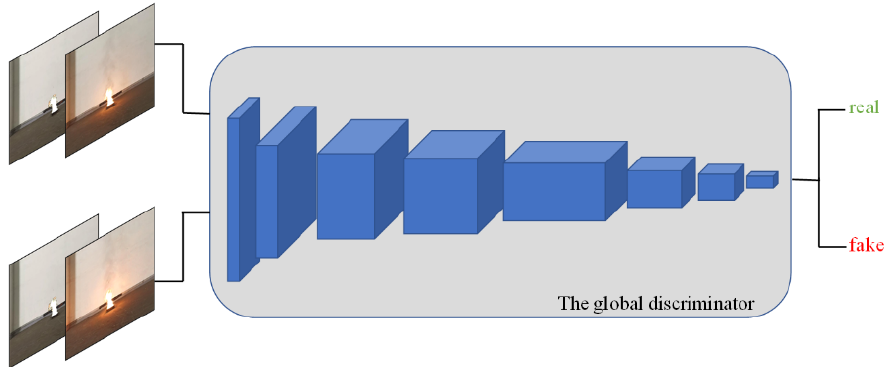
Figure A2. The structure of the global discriminator.